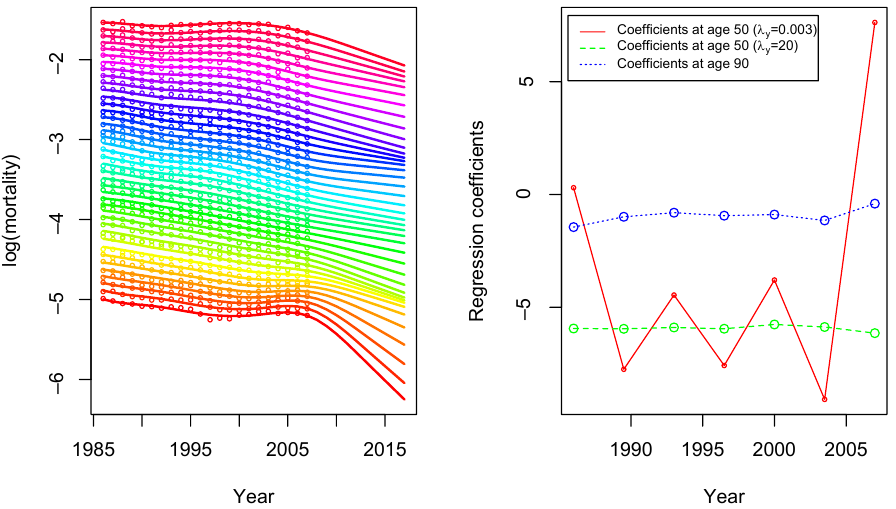
Figure 5. On the left : forecast by the P-spline model with λ y = 20. On the right : regression coefficients in the P-spline model at age 50 with λ y = 0.003 and λ y = 20 and at age